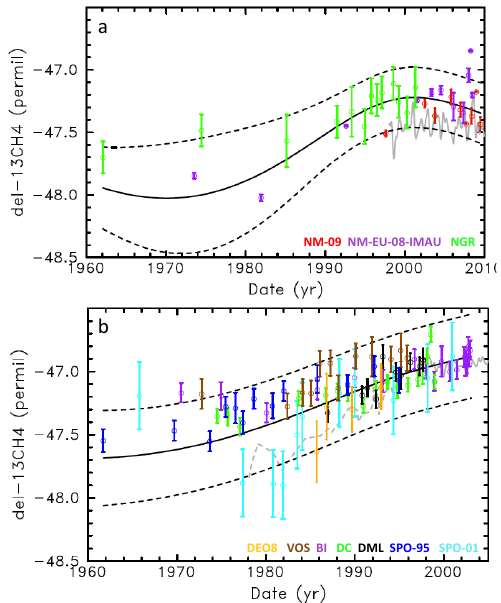
Fig. 6. Firn air δ 13 C(CH 4 ) datasets corrected for isotopic fractionation in firn (diffusion and gravitational settling) as a function of age. (A) NH sites, NM-EU-08 (purple), NM-09 (red), NGR (green). (B) SH sites, DE08 (orange), BI (purple), SPO-95 (dark blue), SPO-01 (light blue), DML (black), DC (green), VOS (brown). The dashed grey line in (B) represents air-archive data from Cape Grim (Francey et al., 1998) and the solid grey lines represent continuous atmospheric monitoring data from the NOAA-ESRL network. Note that the age spread of each data point is not presented here in order to keep the figure readable.